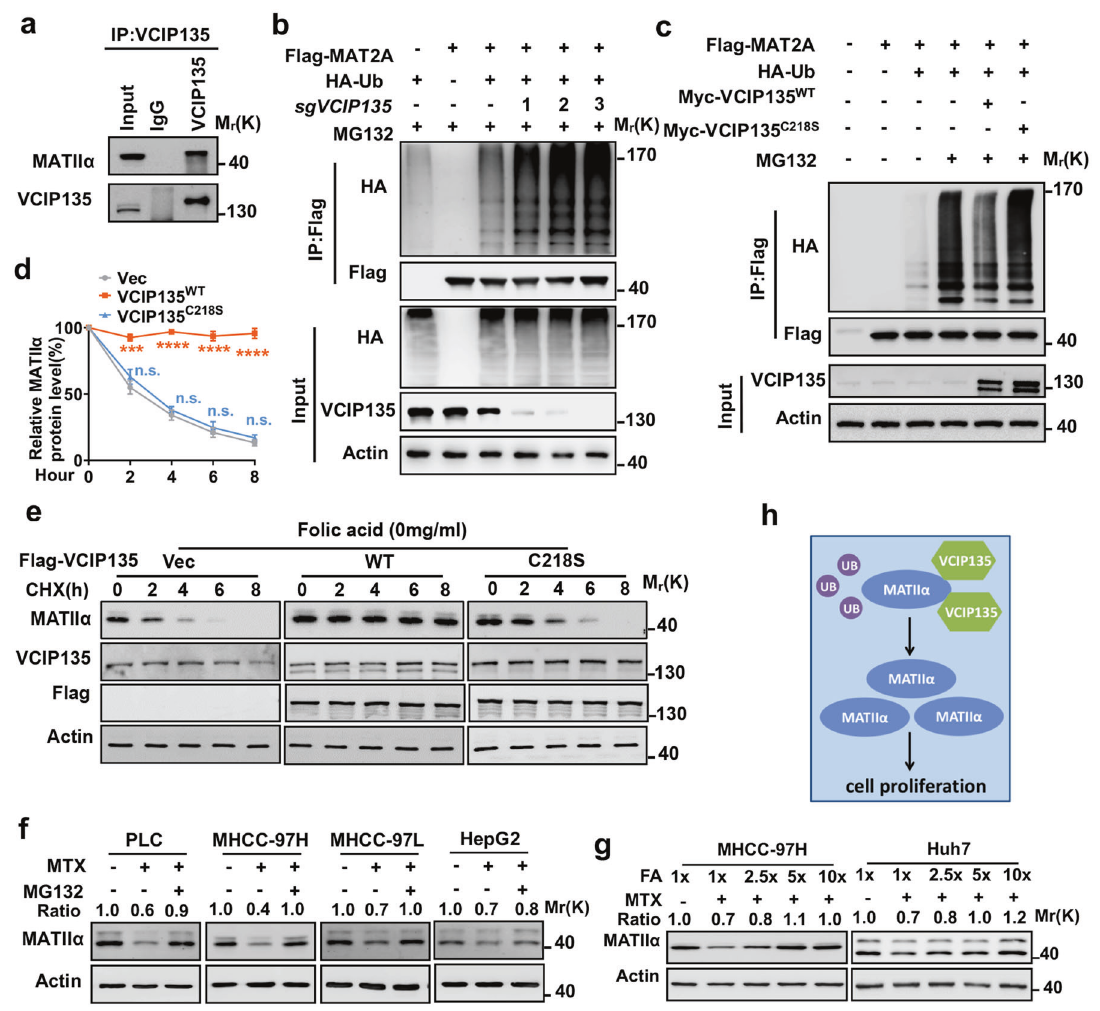
enzymatic-dead mutant C218S decreases MATII α ubiquitylation. HEK293T cells were transfected with the indicated plasmids. d , e VCIP135 WT but not enzymatic-dead mutant stabilizes MATII α upon folate deprivation for 72 h. MHCC-97H cells were cultured under folate-deprived condition, followed by CHX treatment. Mean ± s.d. of n = 3 ( d ) biologically independent experiments, one-way ANOVA test. f MG132 rescues MTX-reduced MATII α protein level in multiple HCC cell lines. g Folate rescues MTX-reduced MATII α protein level in MHCC-97H and Huh7 cells. h Working model. VCIP135 deubiquitylates MATII α in response to folate and induces MATII α accumulation in protein level. Data ( a – c and e – g ) are representative of three independent experiments. n.s. donates for no signi fi cance, *** P < 0.001 and **** P <